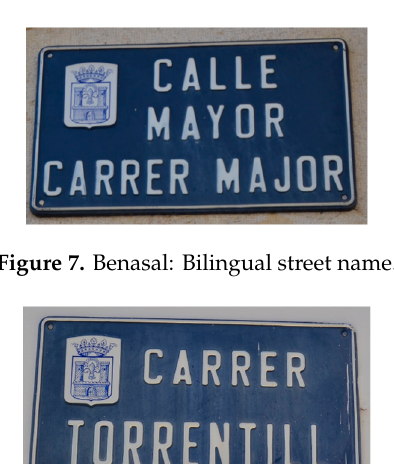
Figure 6. Benasal: Spanish-only street name .